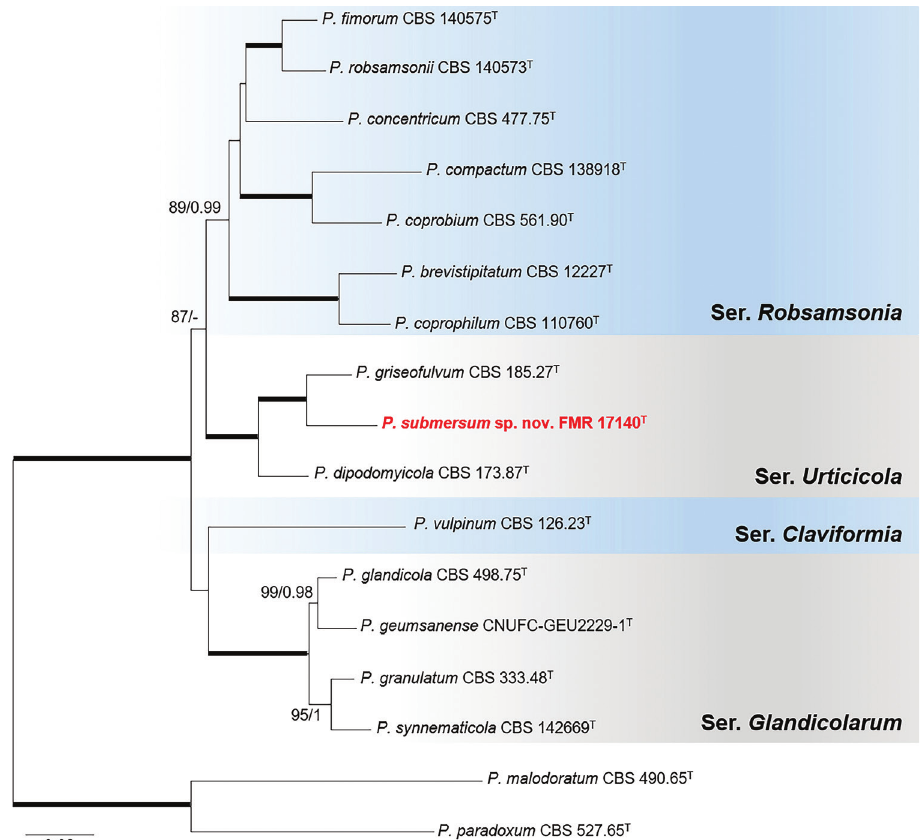
Figure 2. Phylogenetic tree of Penicillium section Robsamsonia based on ML analysis obtained by RAxML inferred from the combined tub 2, cmdA , ITS, and rpb 2 loci. Branch lengths are proportional to phylogenetic distance. Bootstrap support values/Bayesian posterior probability scores above 70%/0.95 are indicated on the nodes. Bold branches indicate bs/pp values 100/1. The tree is rooted to P. paradoxum CBS 527.65 and P. malodoratum CBS 490.65. The name in red is the new species described in this study. T= Ex-type